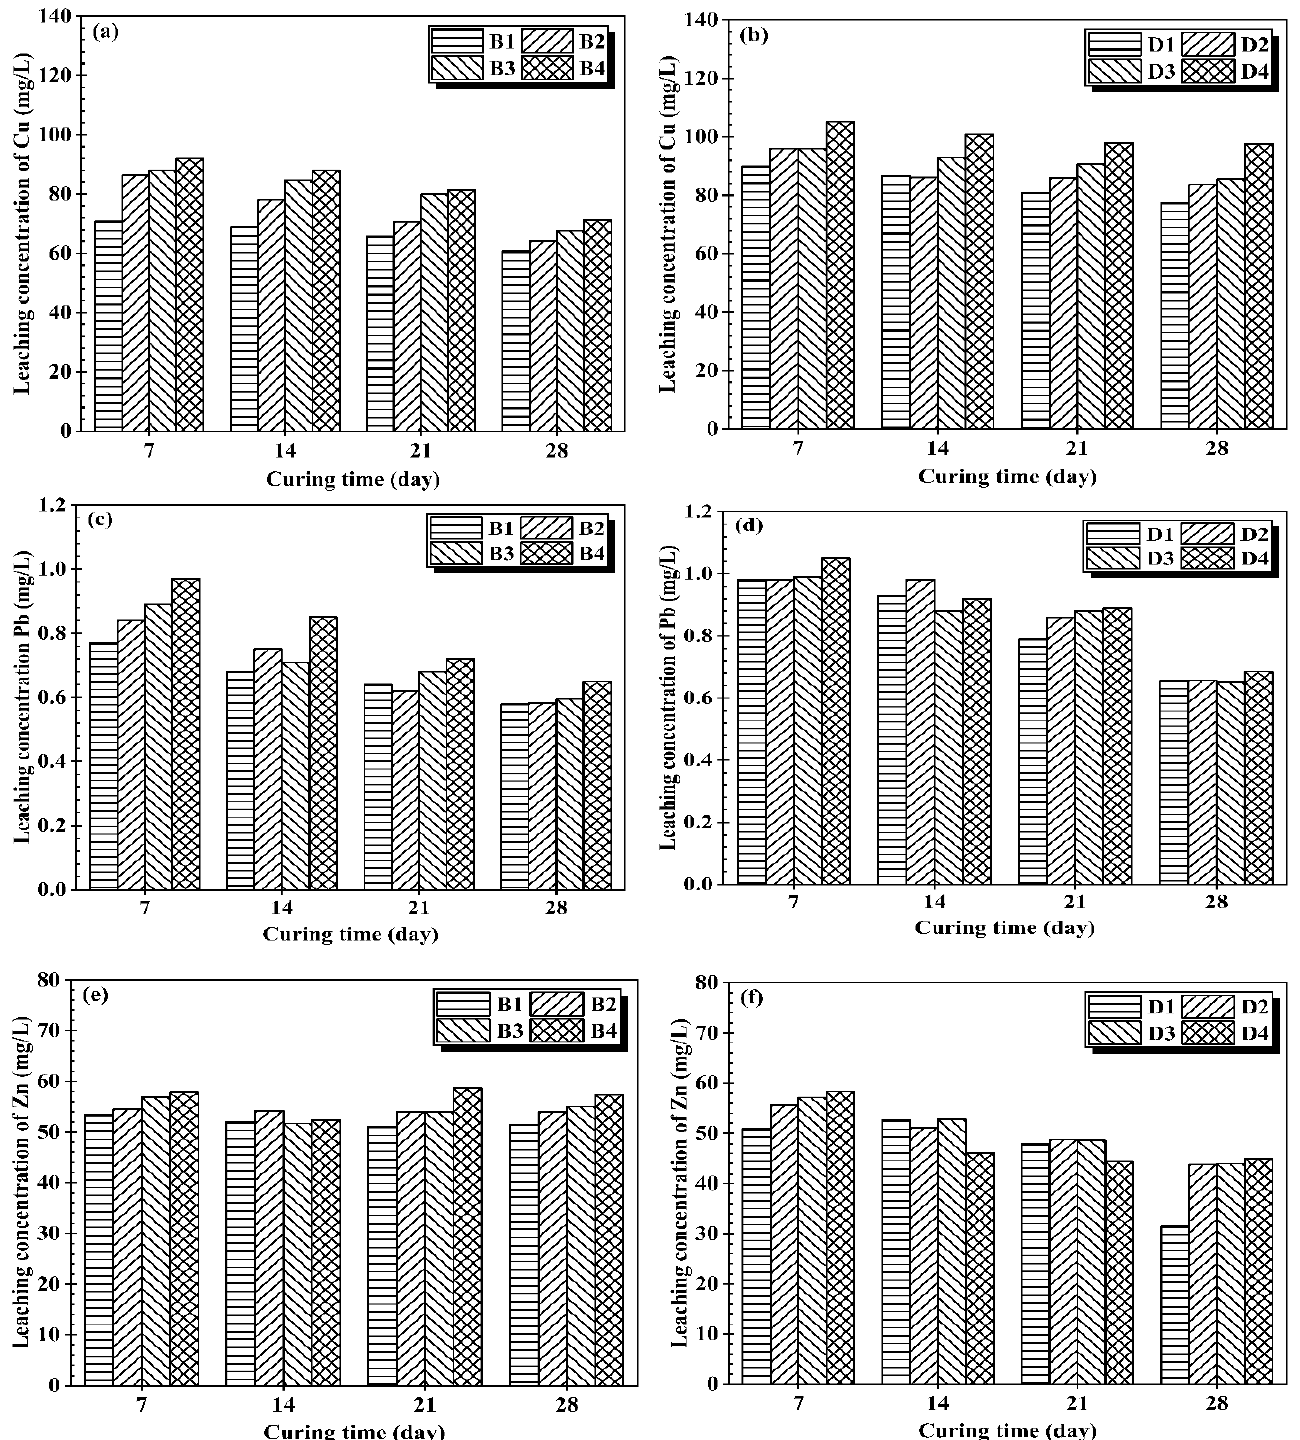
Figure 5. Leaching concentration vs. water content: ( a ) leachate concentration of Cu in OPC samples, ( b ) leachate concentration of Cu in CG samples, ( c ) leachate concentration of Pb in OPC samples, ( d ) leachate concentration of Pb in CG samples, ( e ) leachate concentration of Zn in OPC samples, ( f ) leachate concentration of Zn in CG samples.